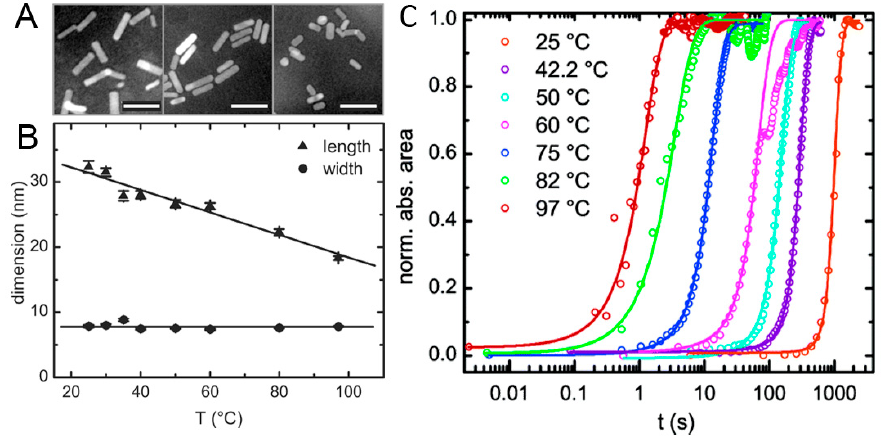
Figure 3. ( A ) TEM images obtained from gold nanorods synthesized at 25 °C, 50 °C, and 97 °C from left to right. The scale bars indicate 50 nm. ( B ) Particle dimension as obtained from TEM analysis. The error bars represent the error in the mean value of the distribution of the respective dimension. ( C ) Evolution of the integrated absorbance vs. time for nanorods synthesized at different temperatures. The solid lines are sigmoidal fits to the experimental data points [44].